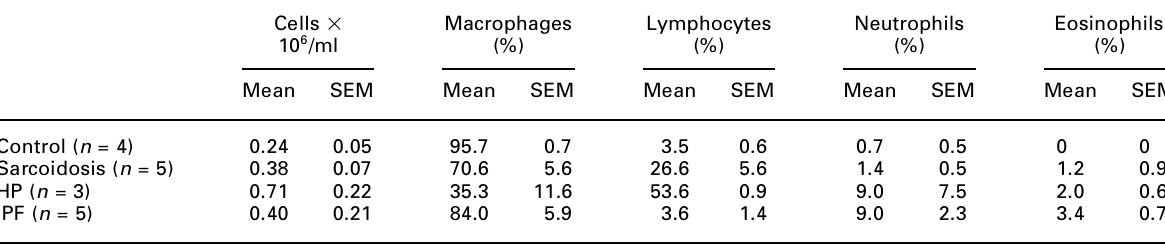
Table 1. Basic bronchoalveolar data of the cases studied